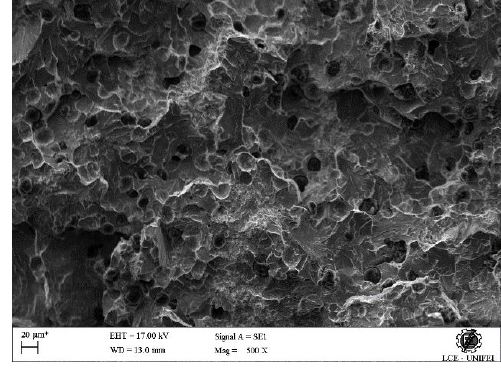
Figure 37. Fractured surface of Cr/Cu.